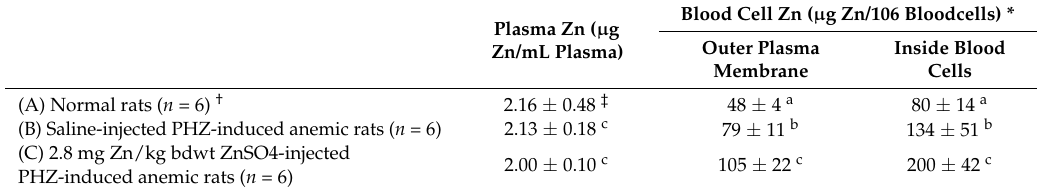
Table 2. Change of Zn level in the blood of the ZnSO 4 -injected PHZ-induced anemic rats.